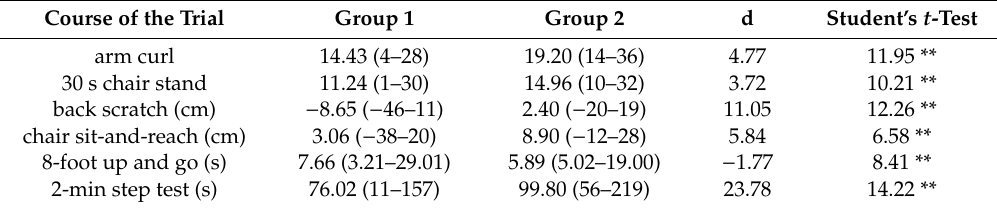
Table 3. Di ff erences in the level of functional fitness among the older female adults.